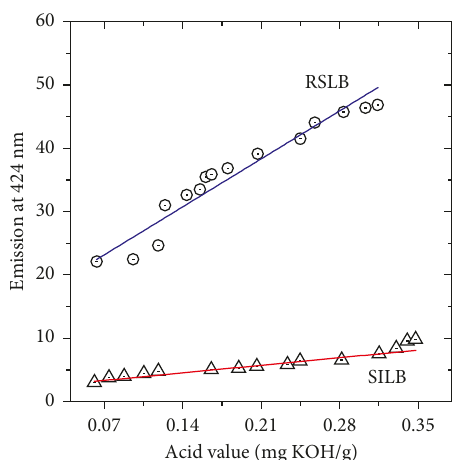
Figure 8: Fitting for the linear correlation between emission at 424nm and acid value for RSLB and